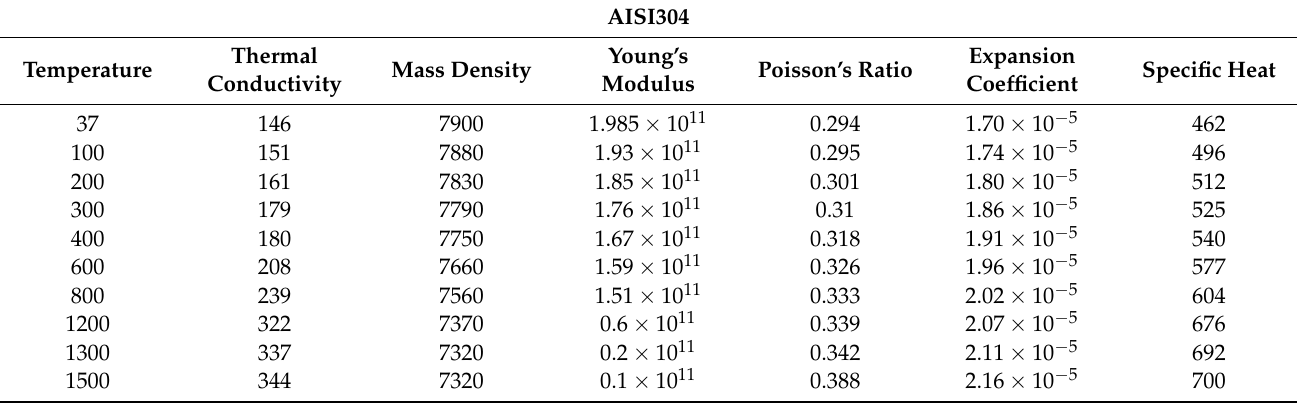
Table 2. Temperature-dependent Young’s modulus, specific heat, Poisson ratio, thermal conductivity, expansion coefficient, and mass density for AISI304 [17].